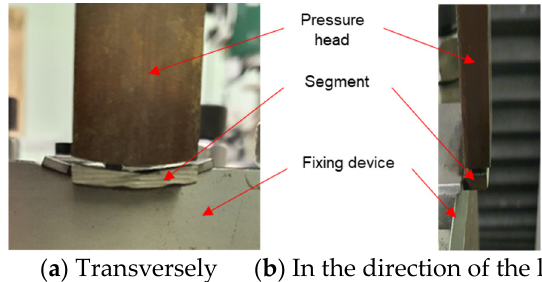
(4) Table 5. Summary of energetic characteristics. Character